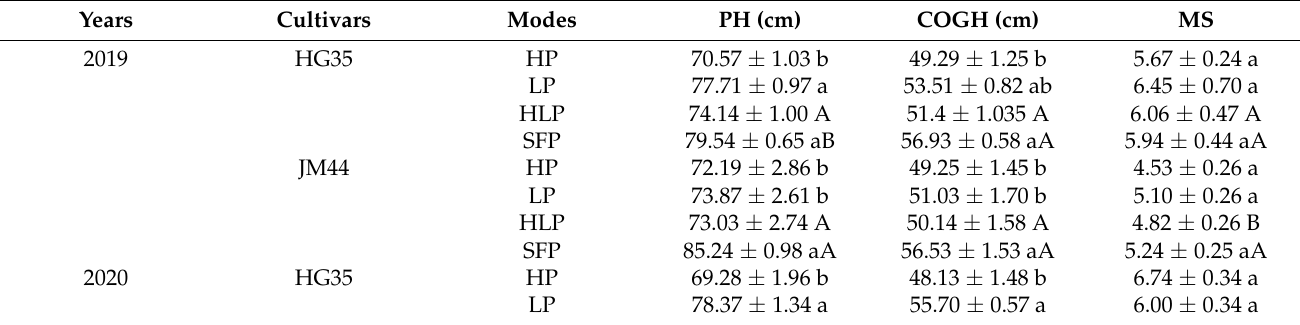
Figure 4. Effects of sowing modes, cultivars, and their interactions on plant height, the center of gravity of height, and mechanical strength. HG35: Hengguan 35; JM44: Jimai 44. HLP: high-low-plot sowing mode; SFP: small-flat-plot sowing mode. The same lowercase letters indicate that the difference between sowing modes was not significant. The same uppercase letters mean the difference between cultivars was not significant. Table 2. Analysis of variance for sowing modes, cultivars, and their interactions on plant height, the center of gravity of height, and mechanical